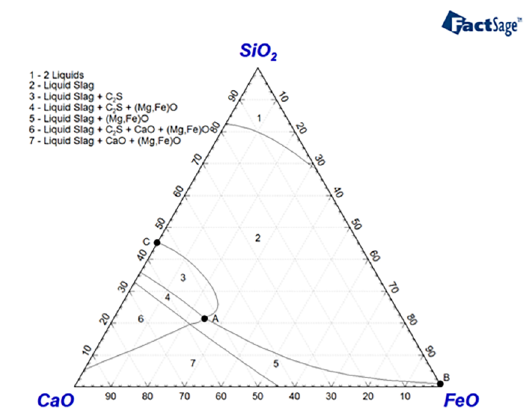
-FeO pseudo-ternary diagram at 5% Al 2